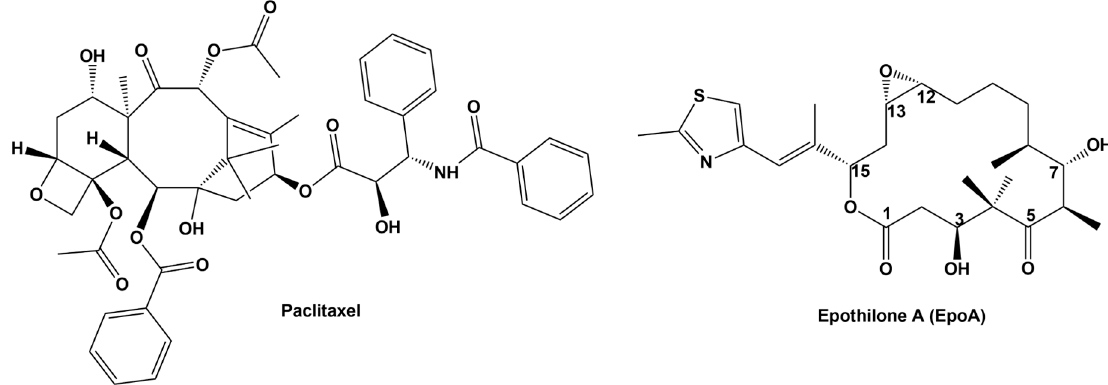
Figure 1. Chemical Structure of the natural Epothilone A and the taxane Paclitaxel.